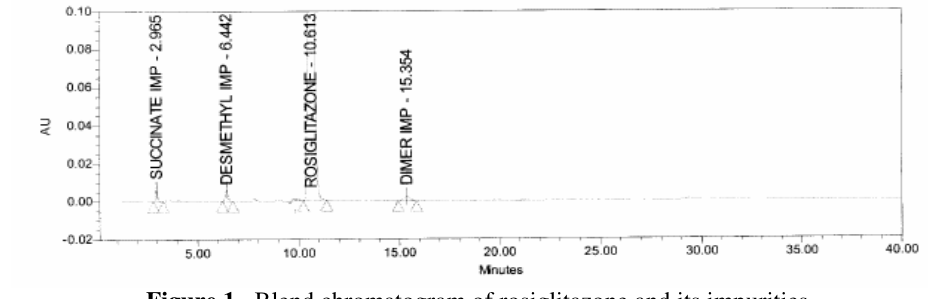
Figure 1. Blend chromatogram of rosiglitazone and its impurities Table 1. IR and mass spectral data of impurities 1, 2 &